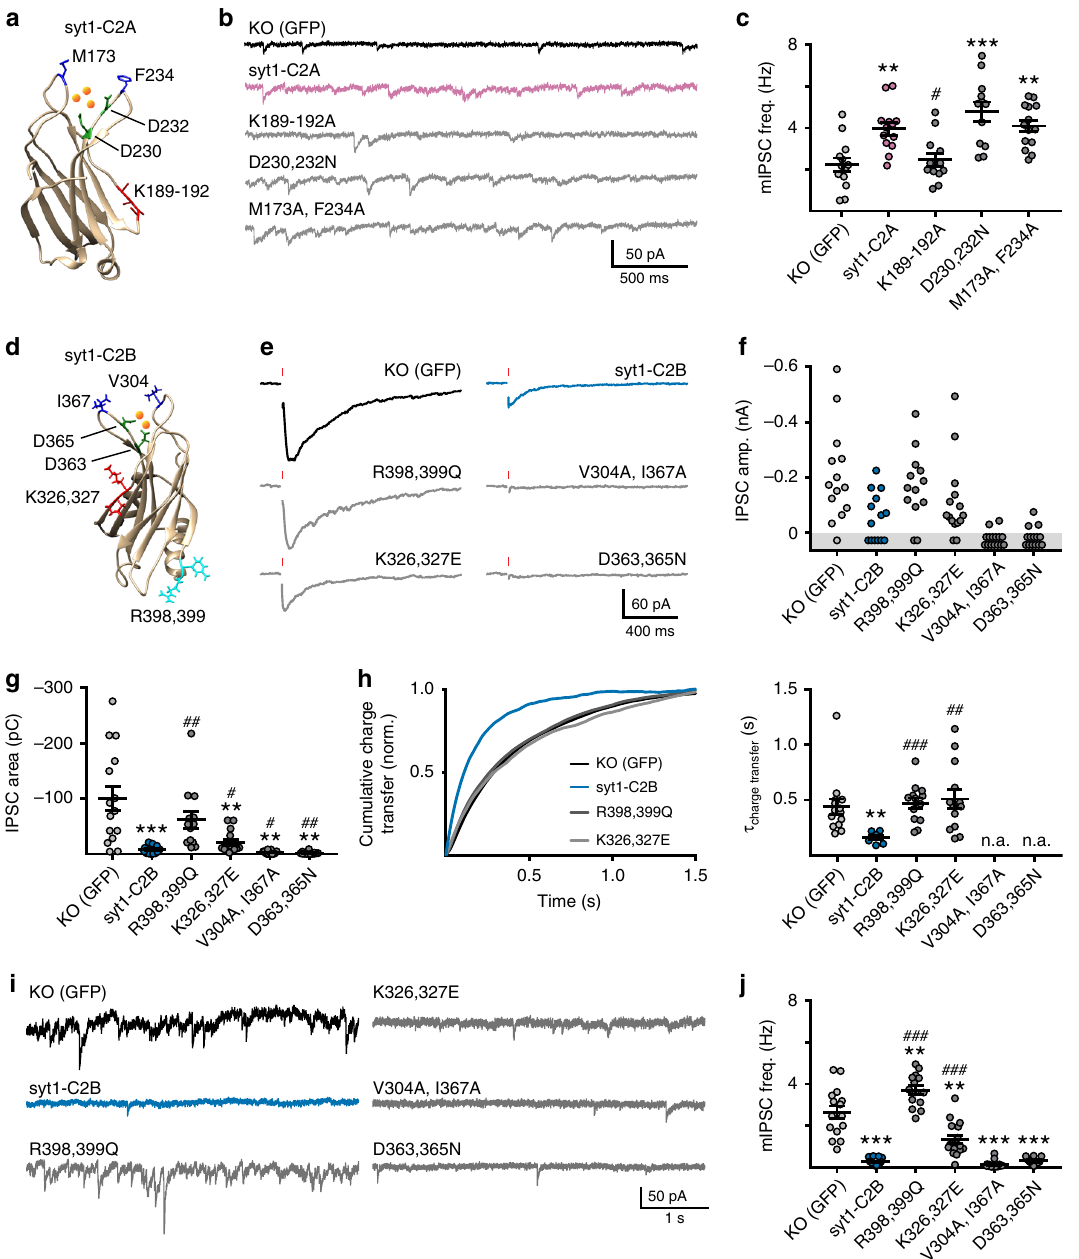
Fig. 5 Mutagenesis of each C2-domain and impact on transmission. a Point mutations were introduced in the syt1-C2A domain-deletion construct. Crystal structure of C2A 34 illustrating the locations of the mutants employed in this study. Ca 2 + ions (orange) were drawn to illustrate the approximate Ca 2 + binding sites. b , c Example traces ( b ) and quanti fi cation ( c ) of the frequency of mIPSCs in syt1 KO neurons expressing the indicated mutant construct of syt1-C2A. d Point mutations were also introduced in the syt1-C2B domain-deletion construct. NMR structure of C2B 73 ; again, the position of each substitution is shown and Ca 2 + ions (orange) were drawn to illustrate the approximate Ca 2 + binding sites. e – h Average evoked IPSCs ( e ) and quanti fi ed amplitudes ( f ), total charges ( g ), and kinetics ( h ) for syt1 KO neurons expressing the indicated mutant construct of syt1-C2B. i , j Example traces ( i ) and quanti fi cation ( j ) of the rate of mIPSCs observed in syt1 KO neurons expressing the indicated constructs. Here, (*) indicates statistical comparisons to neurons expressing the control virus and (#) indicates statistical comparisons to neurons expressing WT syt1-C2A ( a – c ) or WT syt1-C2B ( d – j ). Error bars represent